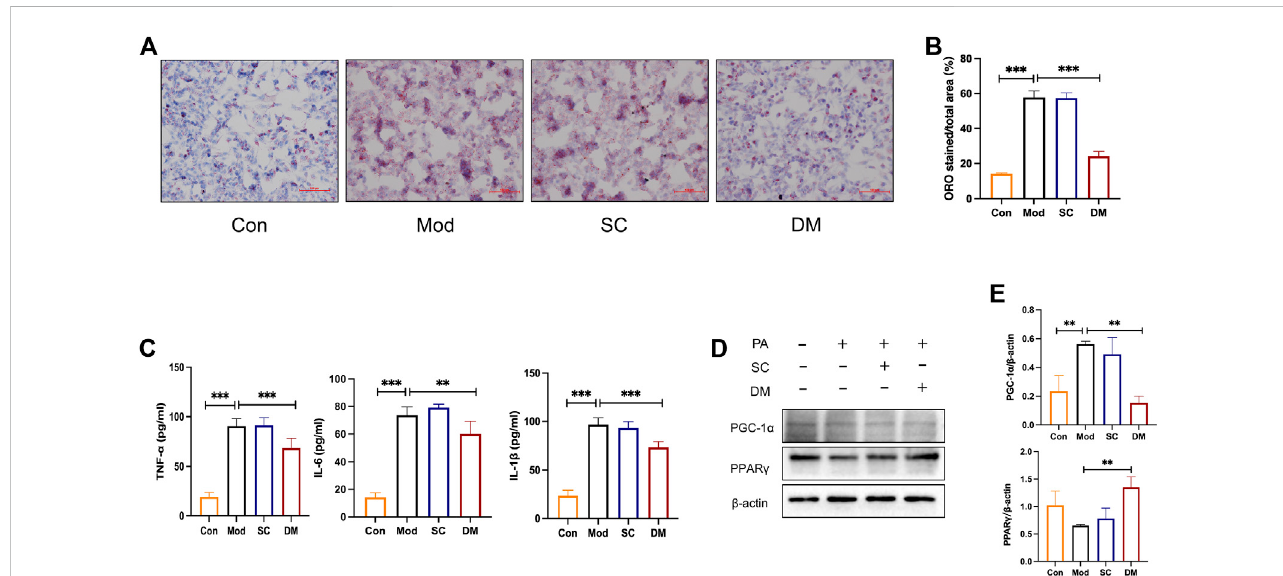
FIGURE 6 (A) Oil Red O staining for HepG2 cells; (B) quantitative analysis of lipid. DM reduced the lipid accumulation in HepG2 cells induced by the 24 h coincubation of PA 250 μ M. Visual observation of lipid content was captured by microscope (×200): the control cells treated with only media (Con), cells treated with PA (250 μ M) for 24 h (Mod), cells pretreated with PA 250 μ M for 24 h and then cultured with serum from mice administered with saline only (diluted to 2.5%) for 24 h (Serum Control, SC), and cells pretreated with PA 250 μ M for 24 h and then cultured with serum DM for 24 h (DM). The quantitative analysis of cellular steatosis was measured through deposited Oil Red O in the cells. Statistical signi fi cance was determined by one-way ANOVA andthevaluesaremean±STD.*** p < 0.001 vs.Modgroup. (C) TheeffectofcellsTNF- α ,IL-1 β andIL-6(pg/mL),** p < 0.01 and*** p < 0.001 vs.Modgroupas assessed by one-way ANOVA with Tukey ’ s multiple comparison test. (D) Western blot images ( n = 3 individual experiments); (E) their statistical analysis of protein expressions of PPAR γ and PGC-1 α in HepG2 cells. ** p < 0.01 vs. Mod group as assessed by one-way ANOVA with Tukey ’ s multiple comparison